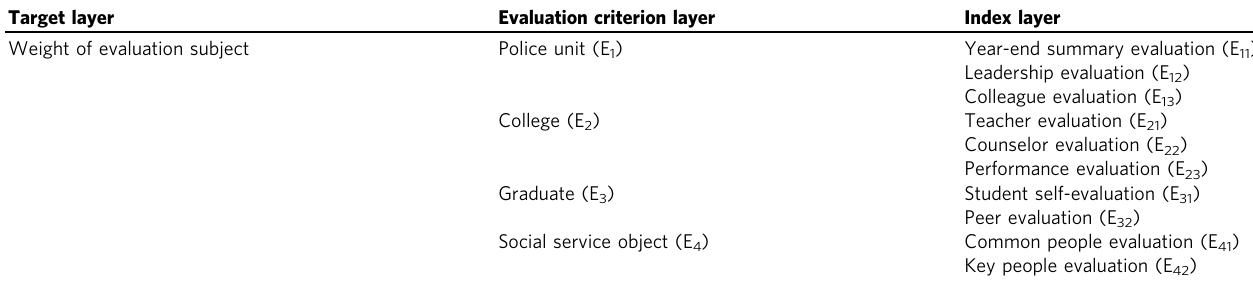
Table 1 Evaluation subject and index